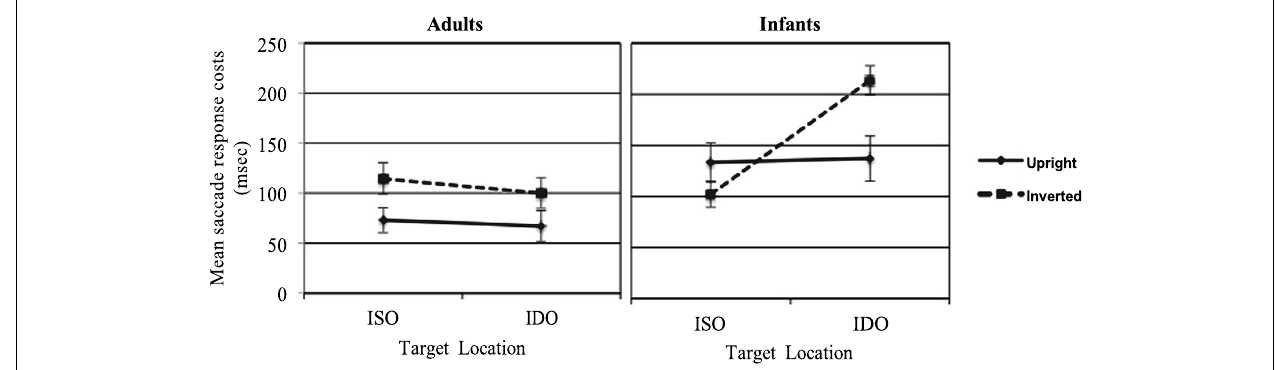
FIGURE 7 |Adults’ and infants’ saccade response costs related to the ISO and IDO conditions for the upright and inverted face stimuli.